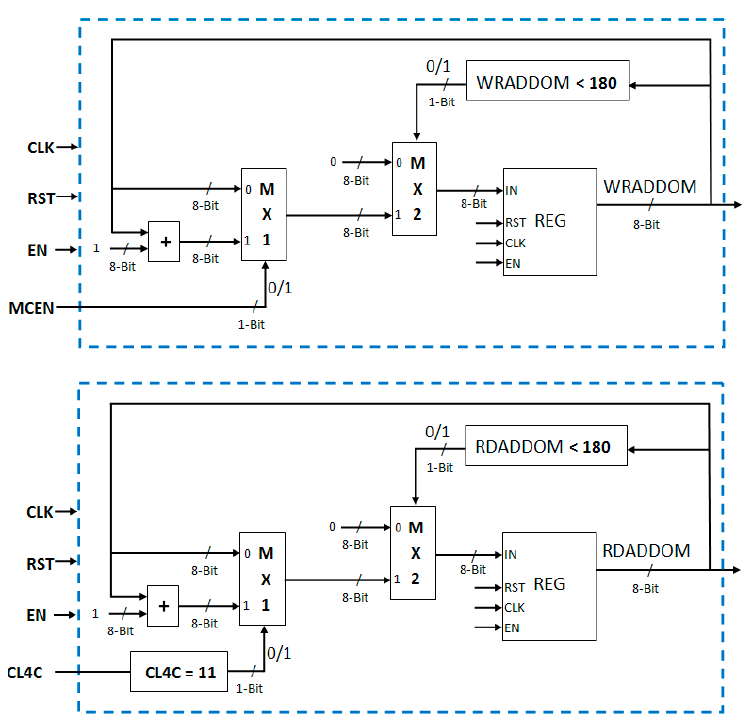
Figure 18. Write address and read address generation logic of output memories.